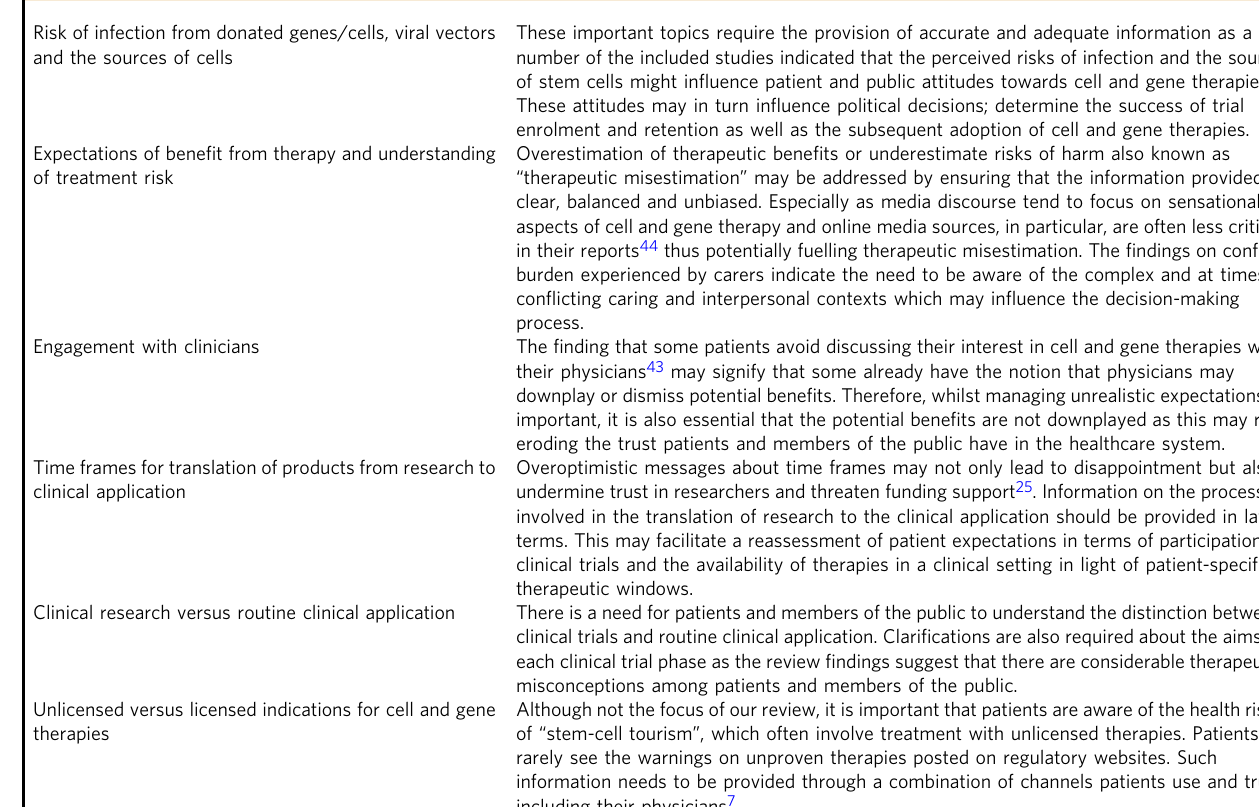
Table 1 Key areas for patients and public education. Risk of infection from donated genes/cells, viral vectors and the sources of cells